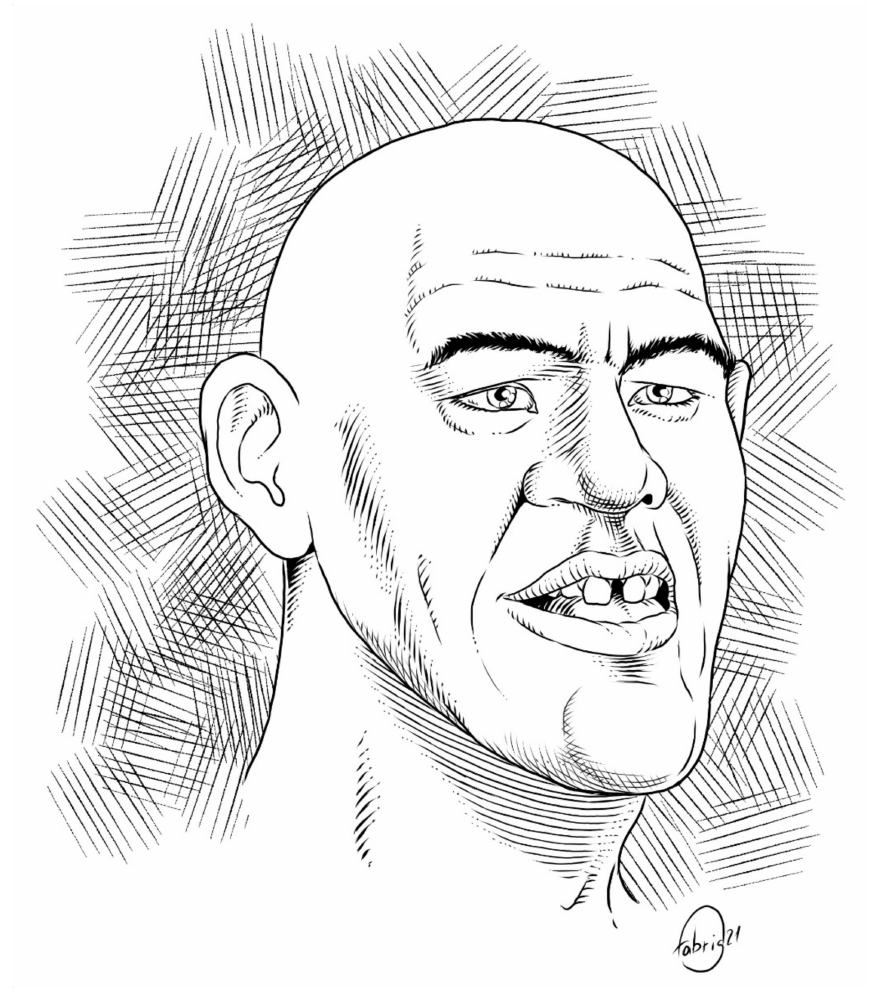
Figure 1. Oro-maxillo-facial features of